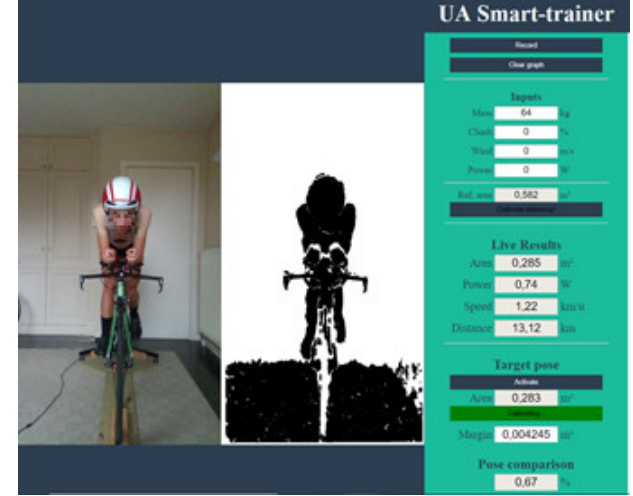
Figure 1. ( a ) A participant in the time trial position on the stationary bike. The angles obtained from the optical mocap are illustrated. The wearable inertial sensors on the participant can also be seen. ( b ) A single sensor unit.